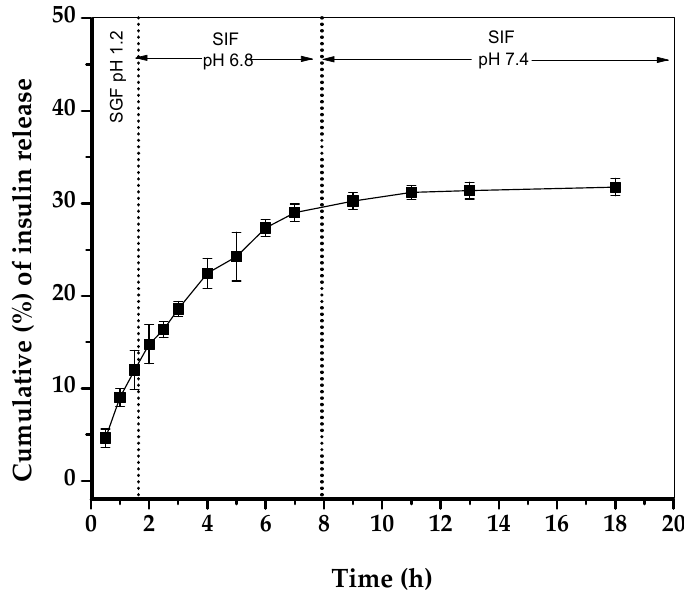
Figure 3. In vitro release profile of insulin from AX microcapsules incubated in simulated gastric fluid (SGF, 2 h) and simulated intestinal fluid (SIF, 6 and 10 h). Data represent the mean ± SD, n = 3.